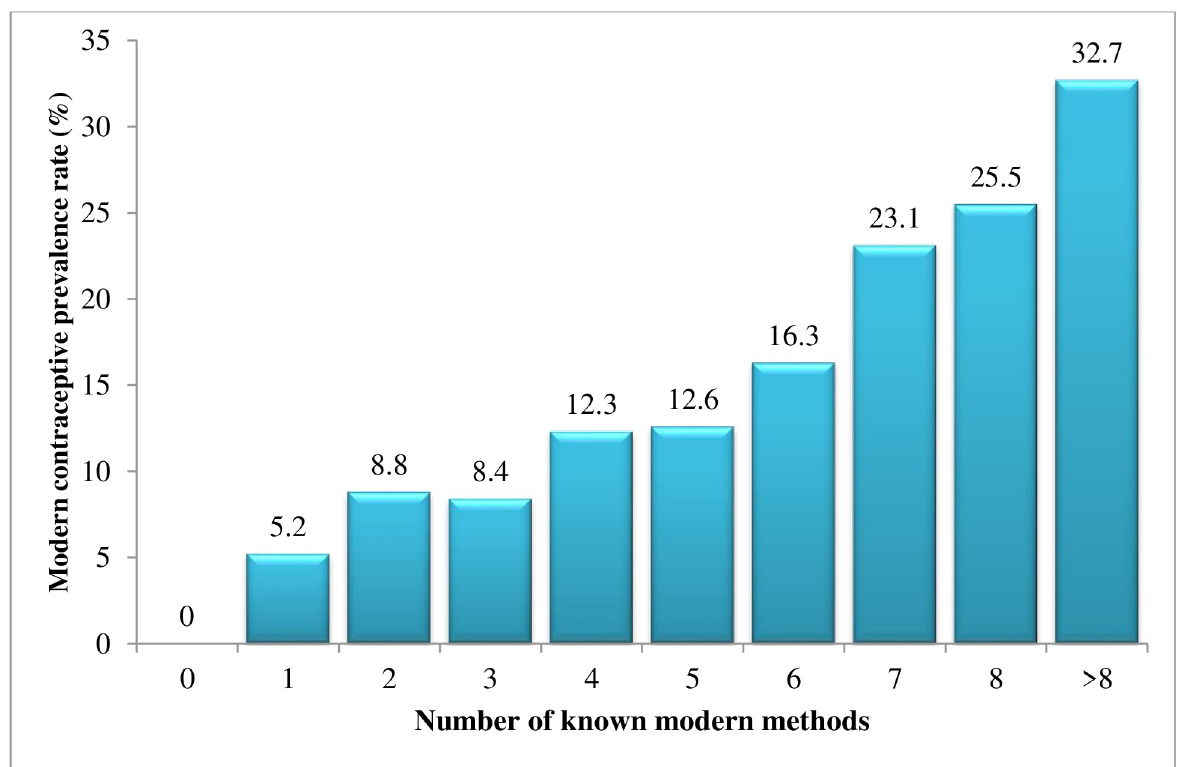
Fig 3. The modern contraceptive prevalence rate by the number of known methods among youth in